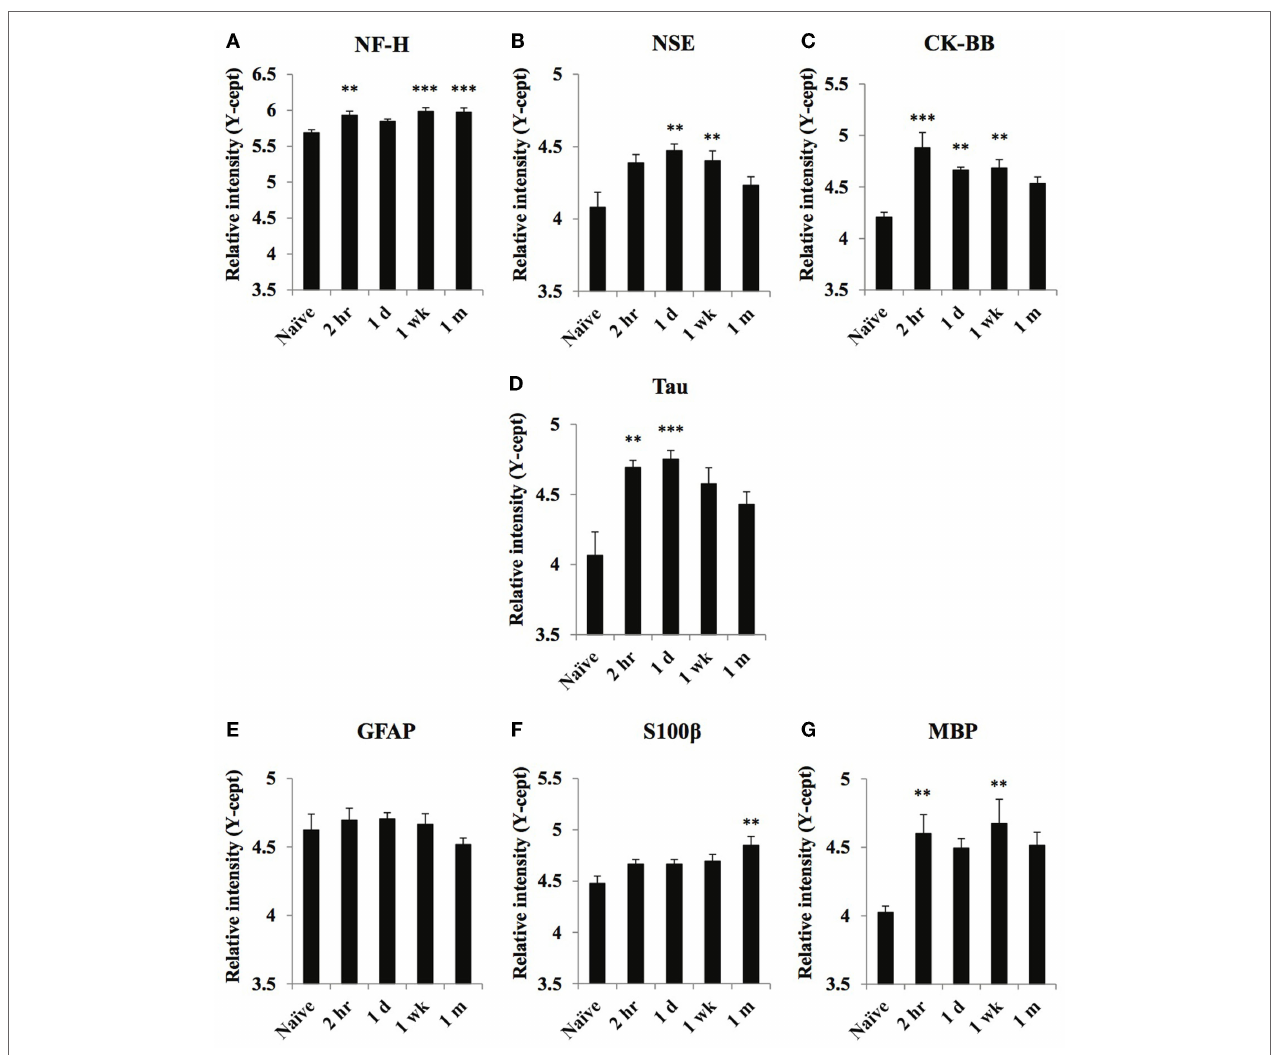
markers GFAP (e) , S100 β (F) , and MBP (g) were assayed using reverse phase protein microarray (RPPM) and are expressed as y -cept values (log 10). Data are presented as the mean ± SEM; ** p < 0.01, *** p <